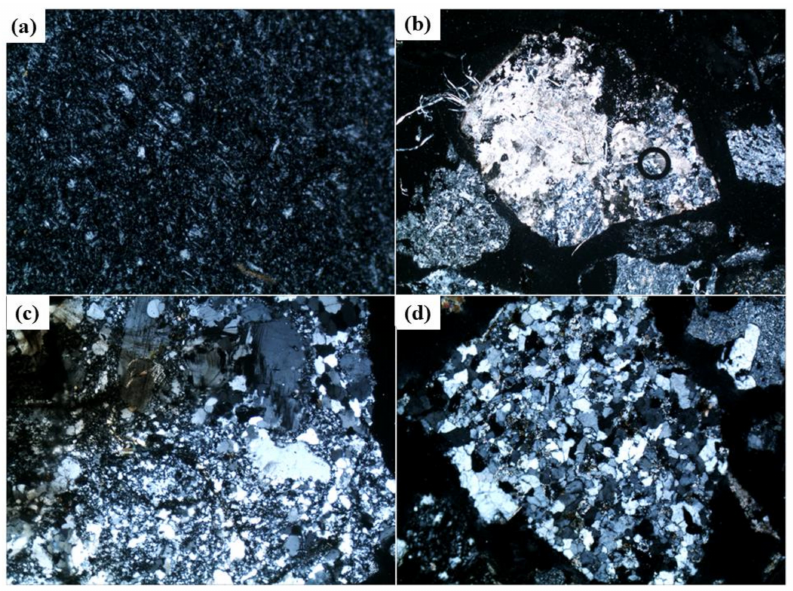
Figure 5. Polarizing microscope images of the four types of aggregates: ( a ) QH1, ( b ) QH2, ( c ) QH3, and ( d )